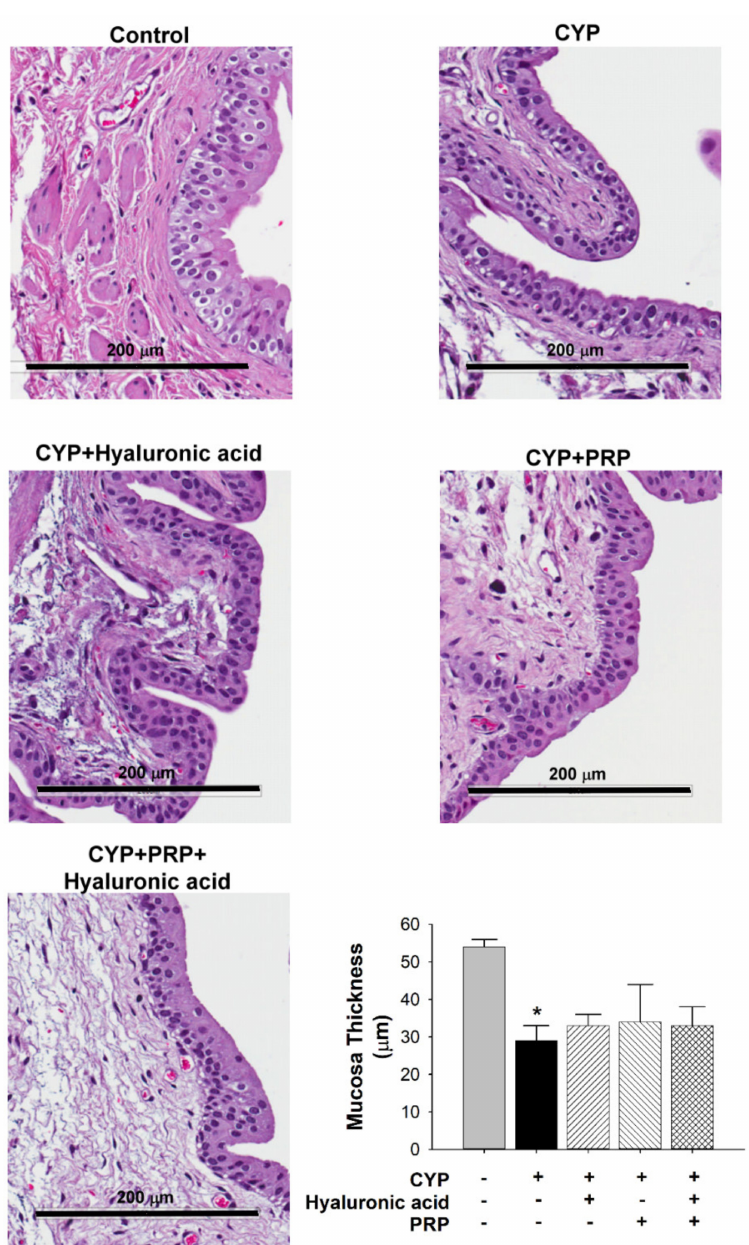
Figure 4. Average thickness of mucosa between saline-injected control; CYP plus intravesical instillation with normal saline; CYP plus intravesical instillation with hyaluronic acid (1 mg / mL); CYP plus intravesical instillation with PRP; and CYP plus intravesical instillation with hyaluronic acid (1 mg / mL) plus PRP groups. Each bar denotes the mean ± SD of six individual rats. * p < 0.05 contrasted to the control